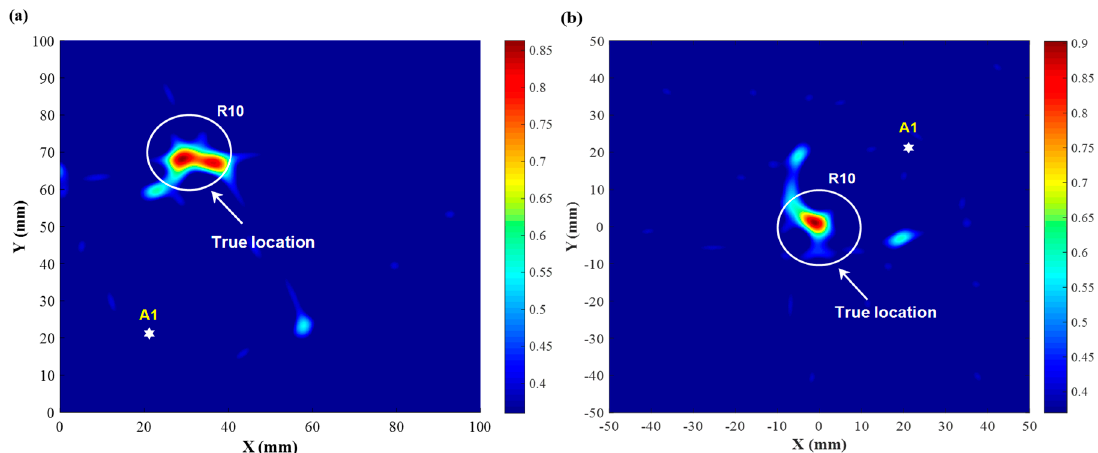
Figure 11. Diagnostic image obtained using the ToF-based PDI algorithm: ( a ) damage at (30 mm, 70 mm); ( b ) damage at (0, 0).